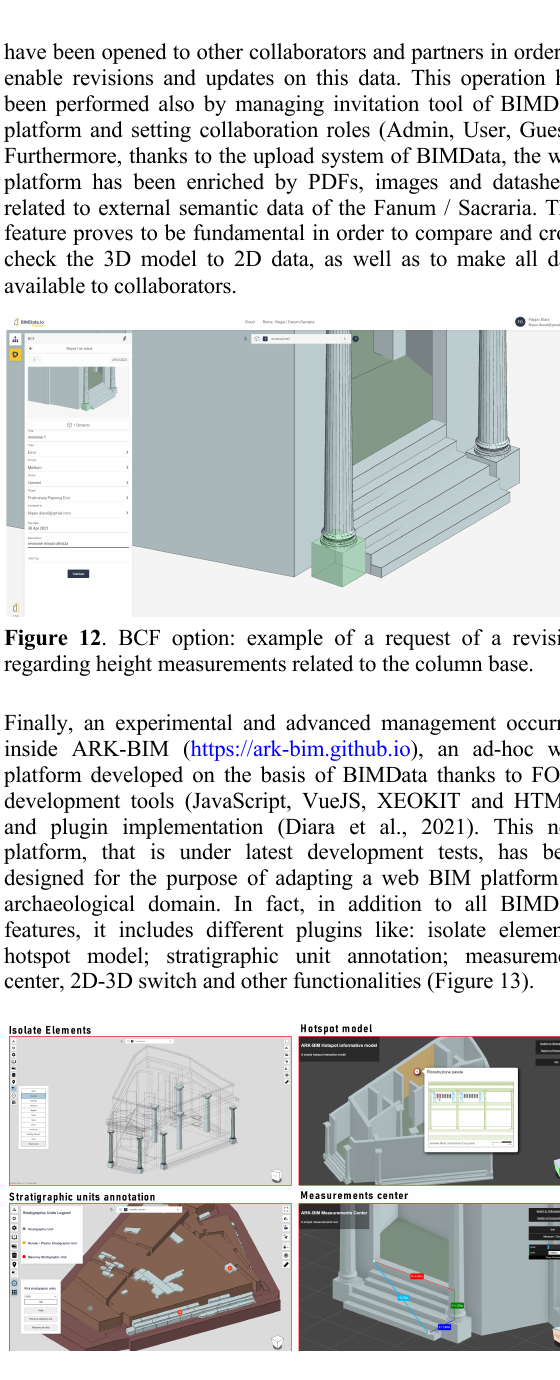
Figure 13 . ARK-BIM main features: isolate elements; hotspot model; stratigraphic unit annotation; measurement